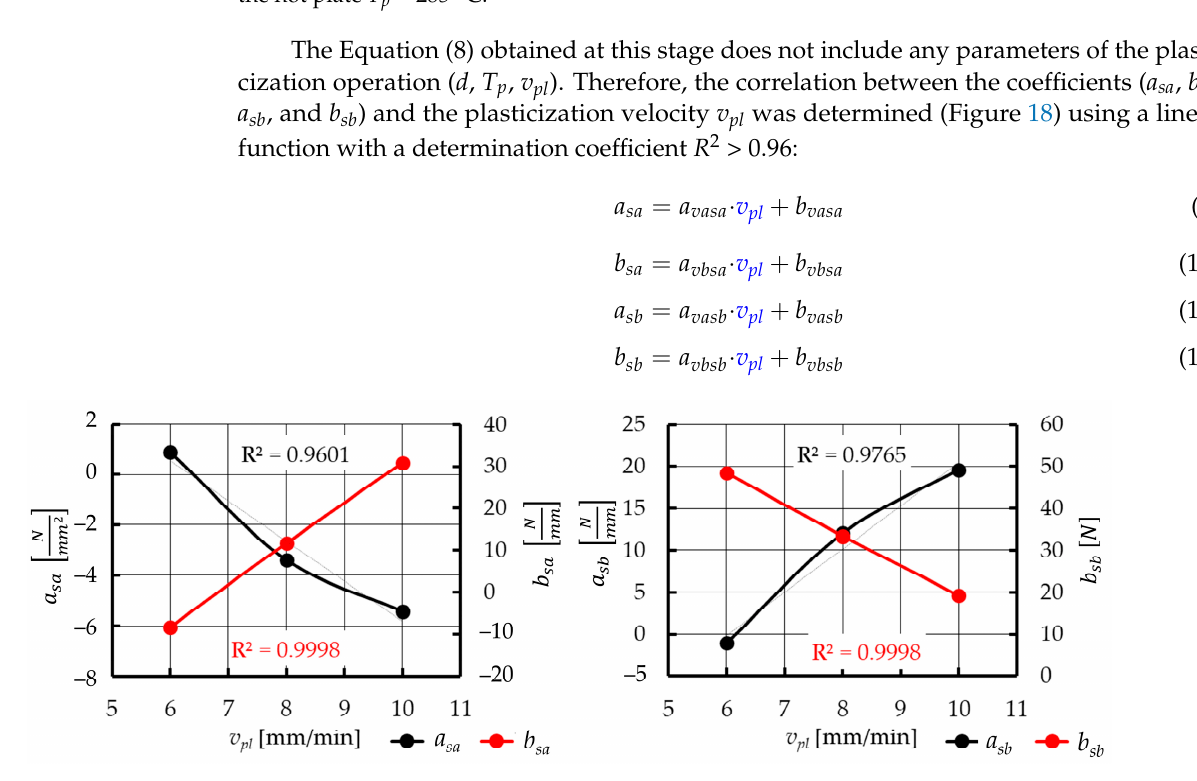
Figure 17. Exemplary correlation between the coefficients a i and b i , and the displacement s for the belt with diameter 12 mm, plasticized with velocity v pl = 10 mm/min and with the temperature of the hot plate T p = 285 °C.